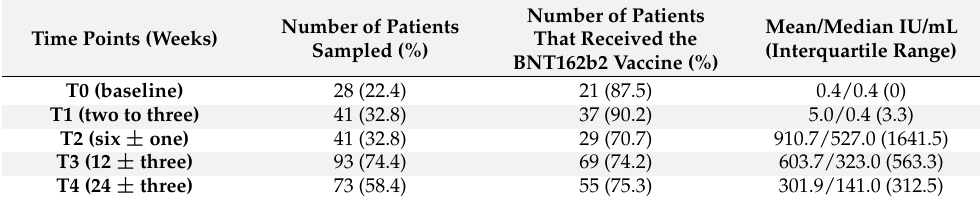
Table A2. Seroconversion in lung cancer